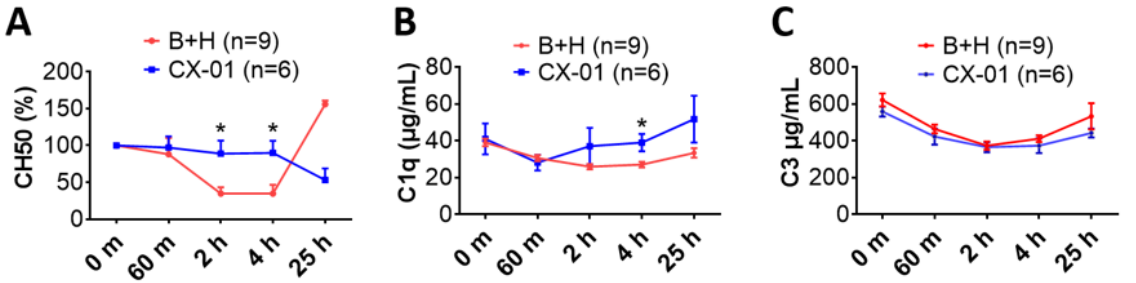
Figure 5. Effects of CX-01 treatment on complement hemolytic activity and complement consumption in the rat model of TH. ( A ) The hemolytic activity (CH50) of sera was measured, and the CH50 at each time point was normalized to the baseline level, which was pre-blast injury and the percentages of normalization are shown; ( B ) C1q blood serum concentrations; and ( C ) C3 blood serum concentrations. Data are presented as mean ± SEM. The individual time points were compared using the unpaired t -test with Welch’s correction, and comparison of the groups was performed by two-way ANOVA. * = p < 0.05 Labels: B + H = blast + hemorrhagic shock; CX-01—treated injured rats (more details in Figure 4A).